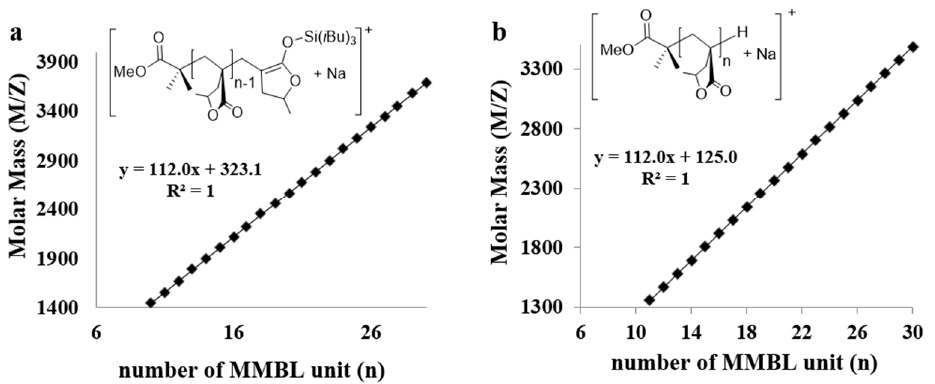
Figure 8. Plot of m / z values from Figure 7 vs. the number of MMBL repeat units ( n ) for major series ( a ) and minor series ( b ).